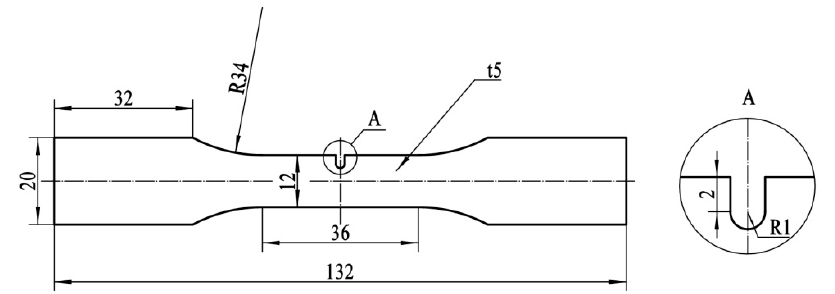
Figure 2. Dimensions of notched specimens.